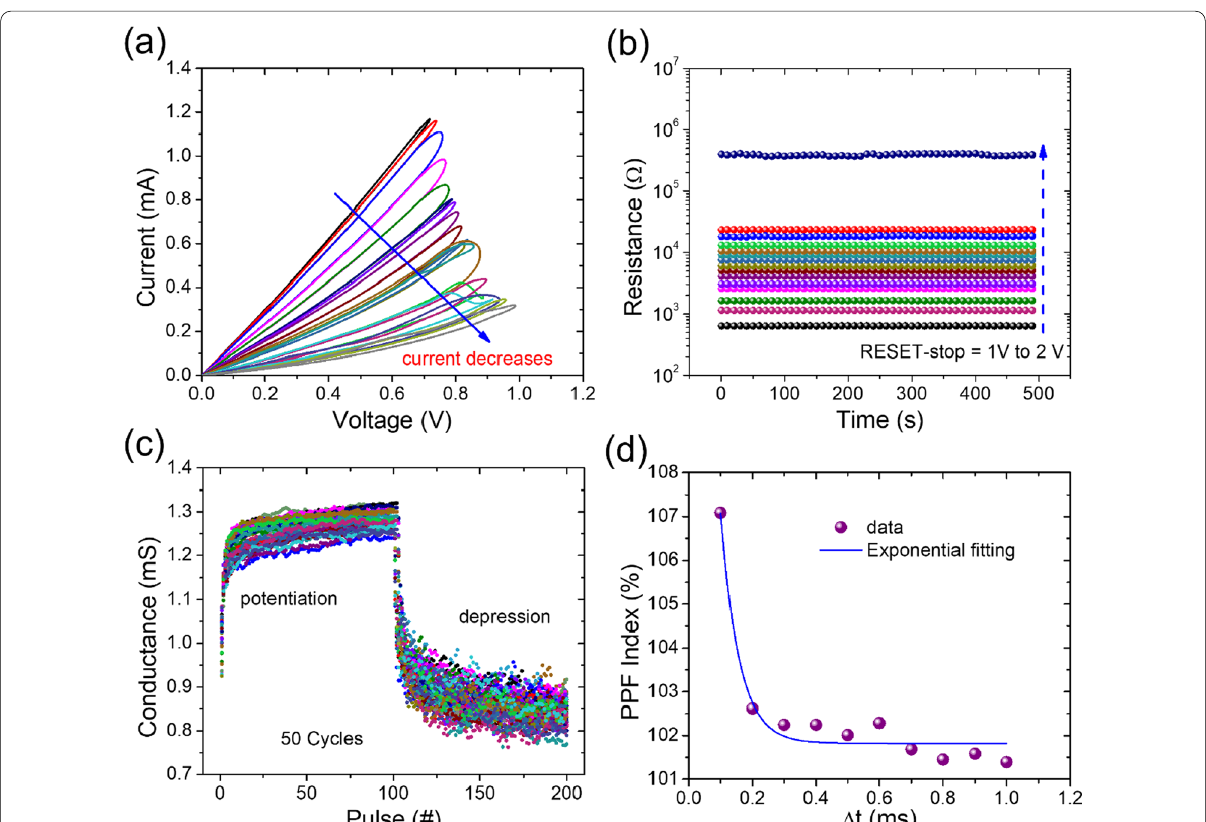
Fig. 7 a Multilevel conductance states during reset process by applying a consecutive increase in reset voltage sweep from 0.7 to 1.0 V. Arrow indicates the sweep direction. The increment of sweep voltage was 0.01 V. b Retention tests were performed at fifteen different HRSs for 500 s. The resistance values were extracted at read voltage of 0.2 V. c The potentiation and depression characteristics under 50 negative pulses ( and 50 positive pulses ( 1.5 V, 500 μs), respectively. d The PPF index vs. pulse interval ∆t, where a series of double spikes with different inter-spike + timings were employed, showing an exponential decreasing